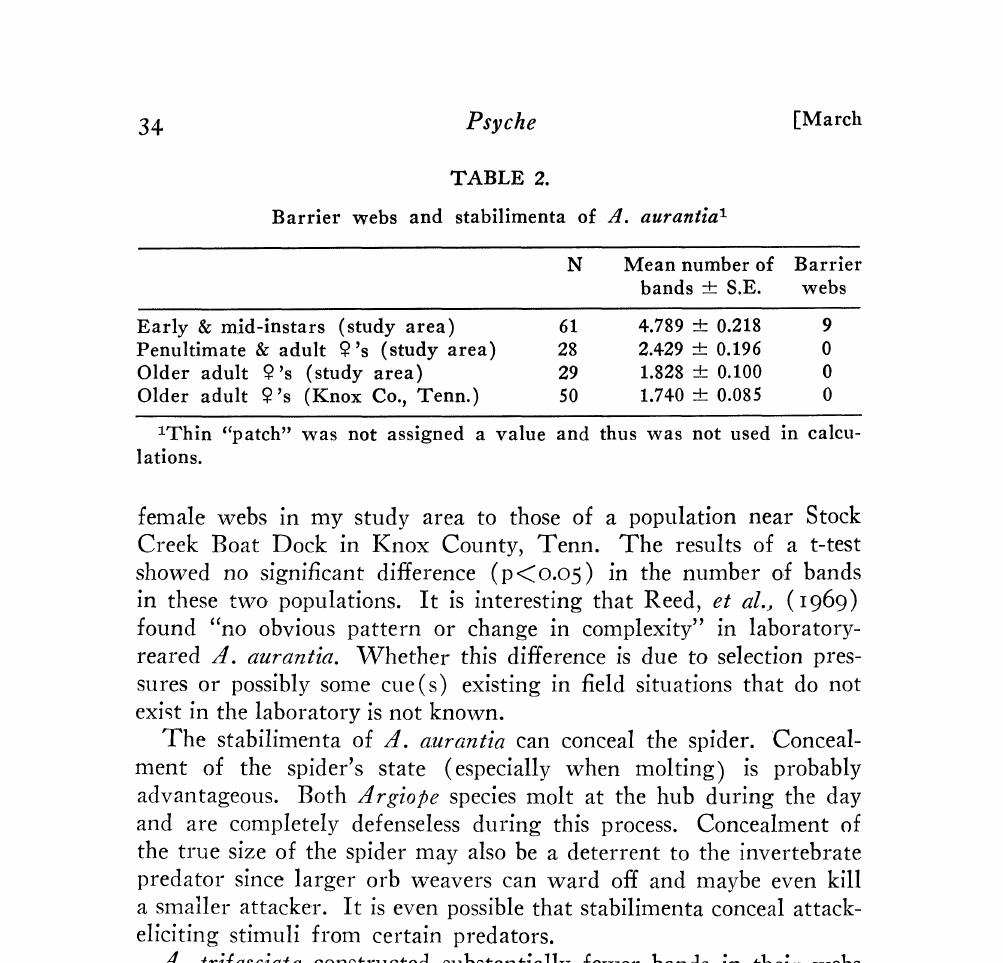
Barrier webs and stabilimenta of d. aurantia 1